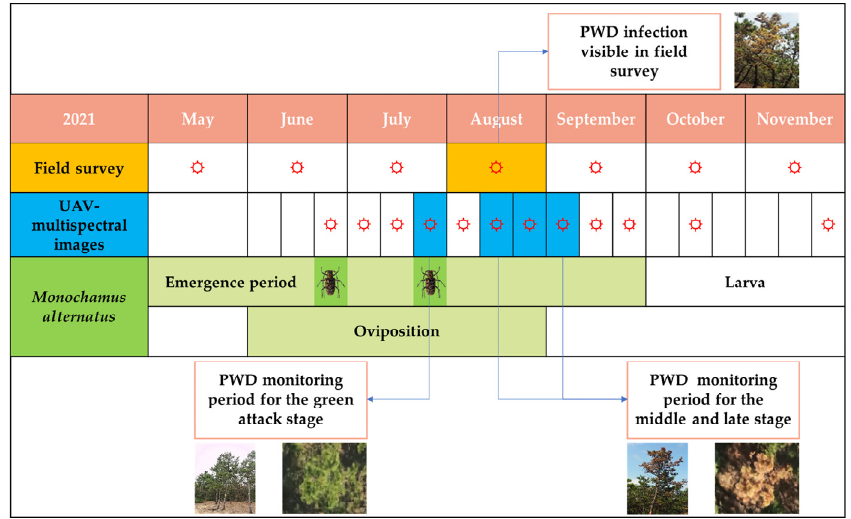
Figure 11. Overview of monitoring period for different PWD infection stage. The patterns indicate data collection dates. Insect patterns indicated peak eclosion time.